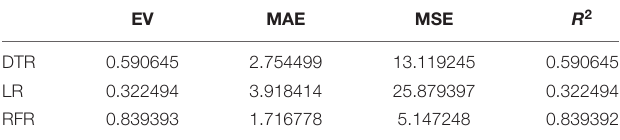
TABLE 5 | Regression index of the agreeableness model.